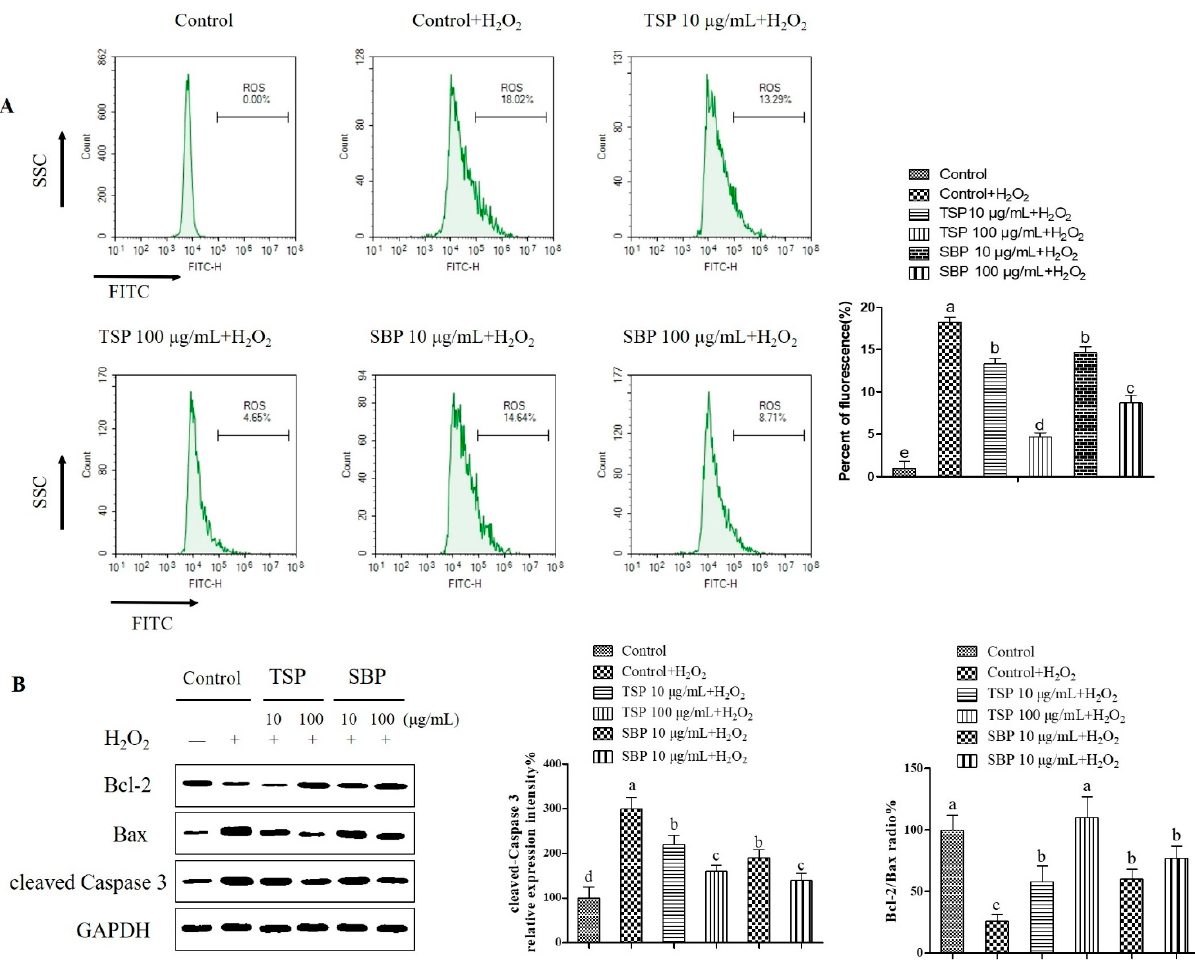
Figure 2. Protection of H 2 O 2 -treated PC-12 cells from mitochondrial-dependent apoptosis by SBP and TSP. 10 μ g/mL and 100 μ g/mL of SBP and TSP were pretreated to cells for 48 h followed by exposure to 250 μ M H 2 O 2 . ( A ) SBP and TSP effect on mitochondrial ROS generation, which was detected by immunofluorescence. ( B ) SBP and TSP effect on protein expression. Cleaved-caspase 3, Bcl-2, and Bax protein expression levels were analyzed by Western blotting. Data are expressed as the means ± SD ( n = 3), results marked with different letters (a, b, c, d and e) are significantly different ( p < 0.05).